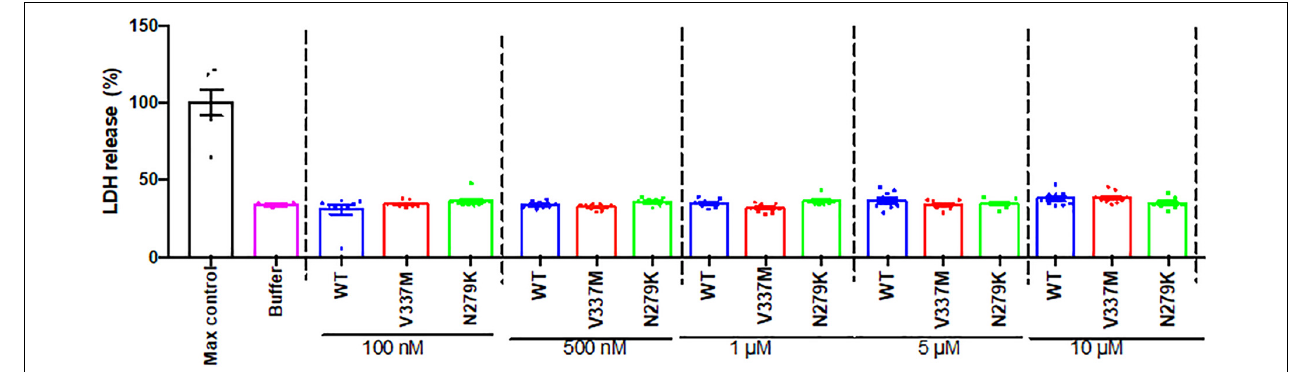
FIGURE 9 | Internalized tau K18 oligomers do not induce LDH-dependent cytotoxicity in SH-SY5Y cells. Increasing concentrations of oligomeric tau K18 variants were applied to SH-SY5Y cells for 72 h, and the cells analyzed for LDH release. We found no significant difference in LDH release between the controls (buffer only or maximum control) and the tau K18 variants at the concentrations studied ( n = 3